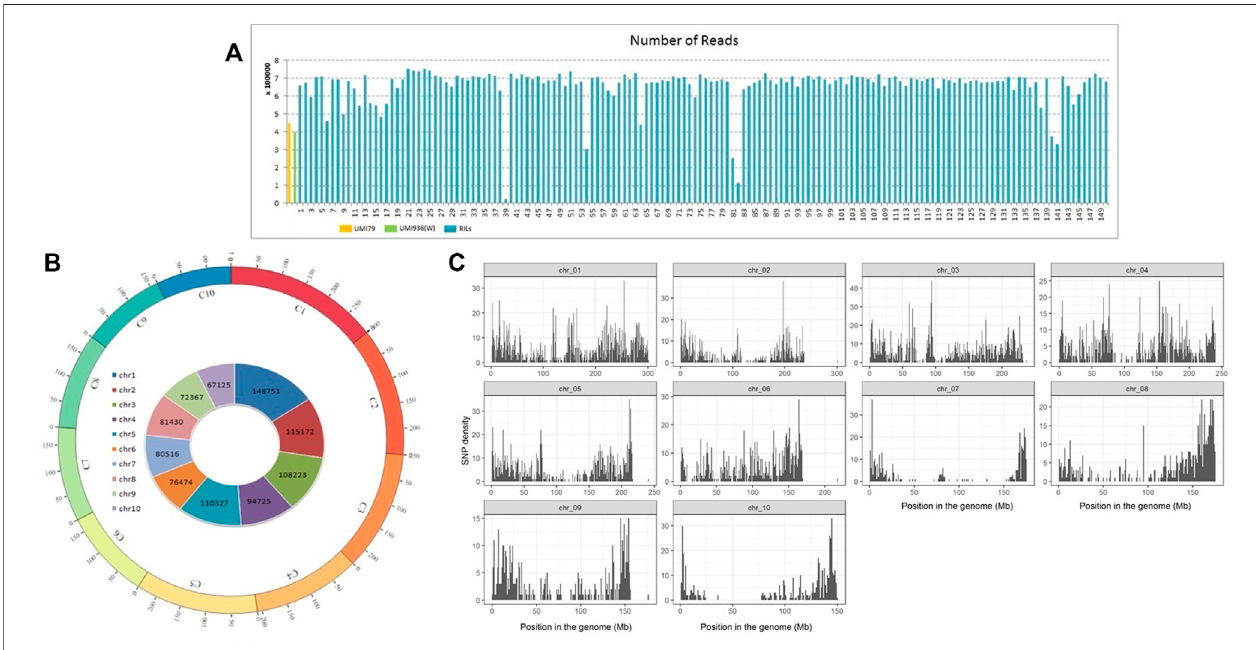
FIGURE2| Numberofreadsandgenomewidedistribution ofSNPsinrecombinantinbredline(RIL)populationofUMI79×UMI936(w).Note; (A) Numberofreads generatedper sampleinUMI79, UMI936(w),andRILpopulation, (B) SNPsinmaizeChromosomes,labeled asC1toC10and eachchromosomeisshown inadifferent colour. The numbers on arches represent the scale for the size of chromosomes in Mb. The numbers on inside circle represents the total number of RAW SNPs in each chromosome, (C) Distribution of fi ltered high quality SNPs in maize chromosomes.